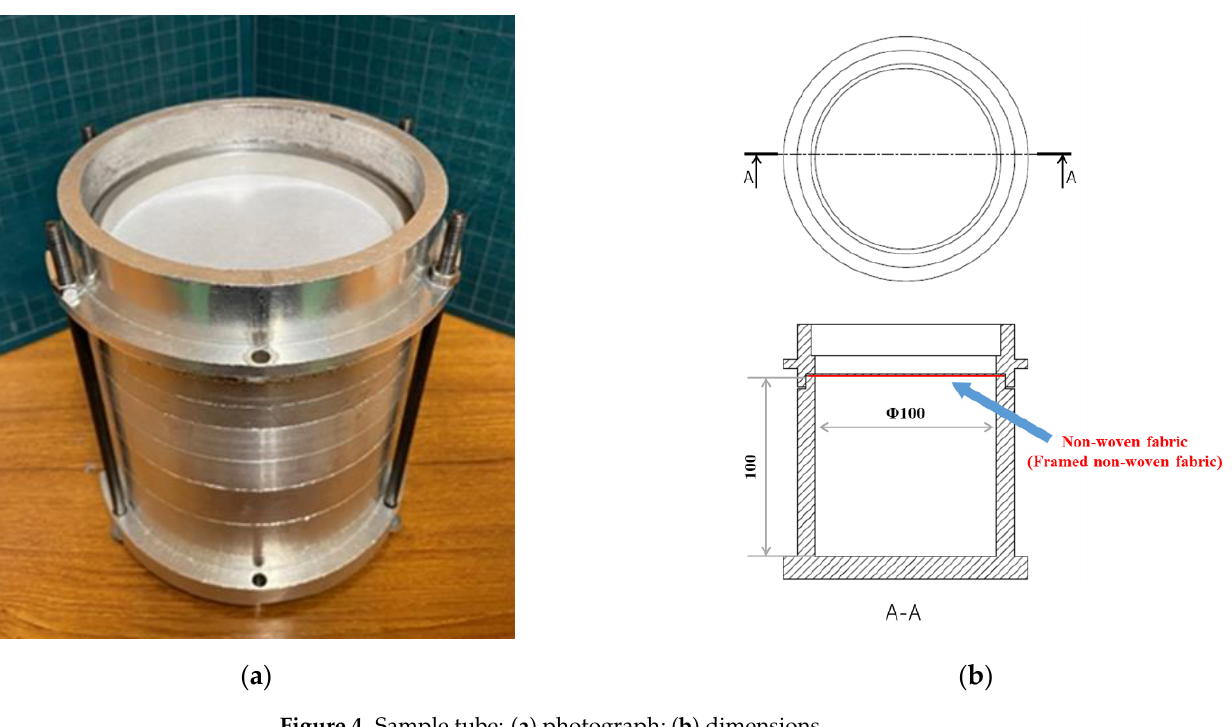
Figure 3. Frame for supporting the nonwoven fabric: ( a ) photograph; ( b ) dimensions of the frame. Figure 4a,b present a photograph and schematic diagrams of the sample tubes, re- spectively. The material of the sample tube was aluminum alloy, and the dimensions were: inner diameter D i = 100 mm, outer diameter 120 mm, and length of the back air space L = 100 mm.